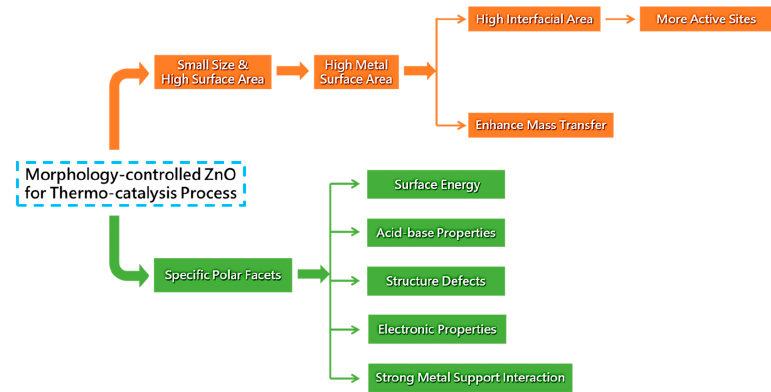
Figure 6. Promotion mechanism illustration of morphology controlled ZnO in the thermo ‐ catalysis